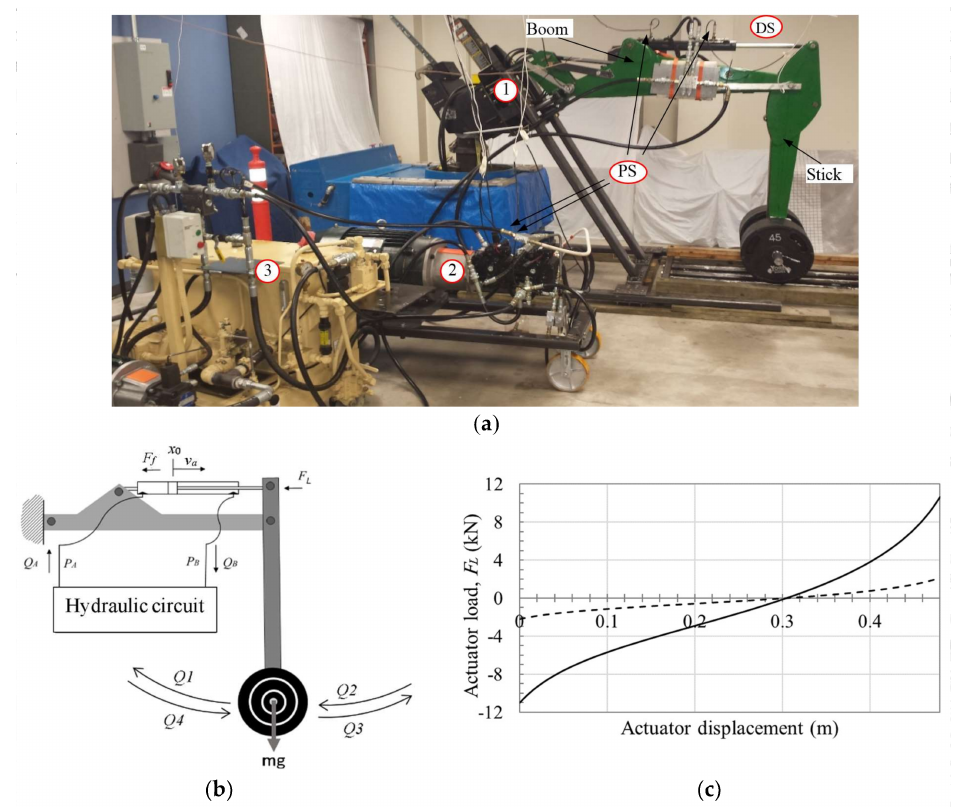
Figure 10. Test rig; ( a ) photo showing the main components: (1) JD-48 backhoe structure, (2) main pump unit, (3) charge pump unit, (PS) pressure sensors, and (DS) displacement sensor; ( b ) setup scheme; ( c ) calculated static load at actuator rod, FL, for 368 kg (solid line) and 41 kg (dashed line) attached masses. Table 1. Specifications of components used in test